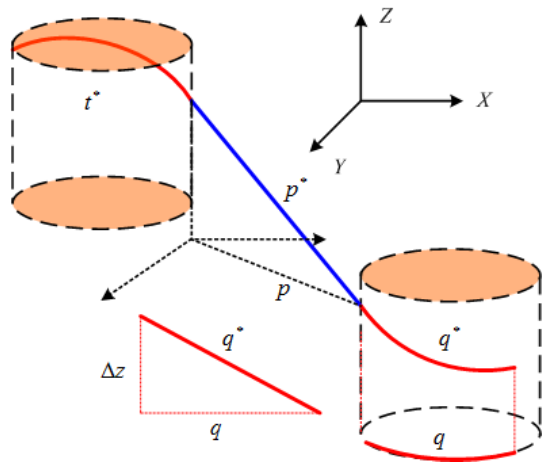
Figure 5. 3D cylindrical spiral